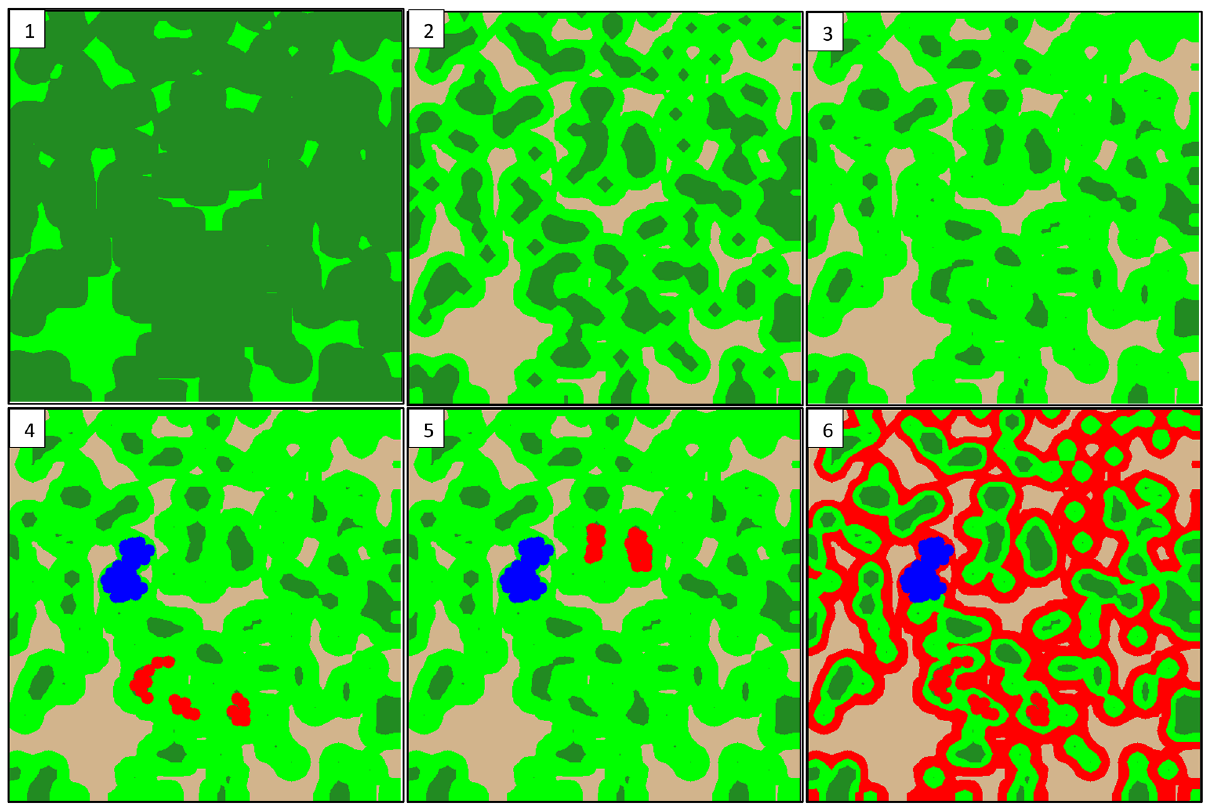
Fig 1. Landscape treatments used to estimate the value of tradable credits at a landscape-scale. 1) Pre-settlement landscape, with 85% high quality habitat (dark green) and 15% matrix habitat (light green); 1) Recovery landscape, with 25% high quality habitat, 55% matrix habitat, and 20% non-forested (gray); 3) Baseline landscape, with 10% high quality, 70% matrix habitat, and 20% non-forested; 4) Bank and Take A landscape, with addition of bank at year 25 as high quality habitat represented in blue and loss of habitat in area A represented in red (take treatment A); 5) Bank and Take B landscape (take treatment B); and 6) Bank and Take A landscape with total matrix habitat lost by year 40 in declining matrix treatment (take treatment Amatrix). Take treatments AB5, BA5, AB20, BA20, Bmatrix are not shown but can be inferred from existing figures.